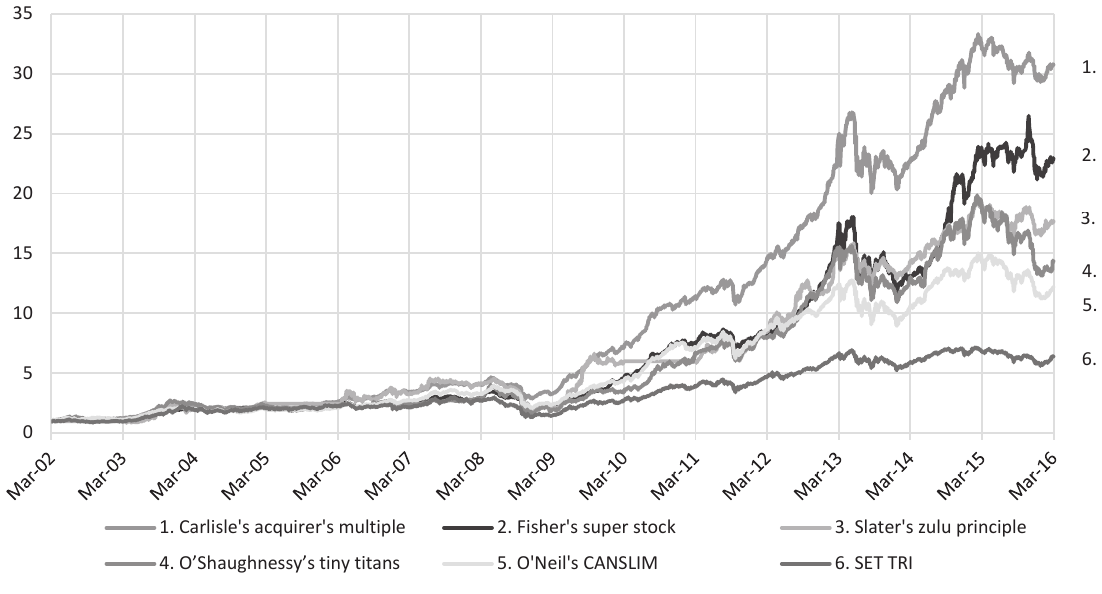
Figure A2. Accumulated value of each portfolio of the SET TRI over 14